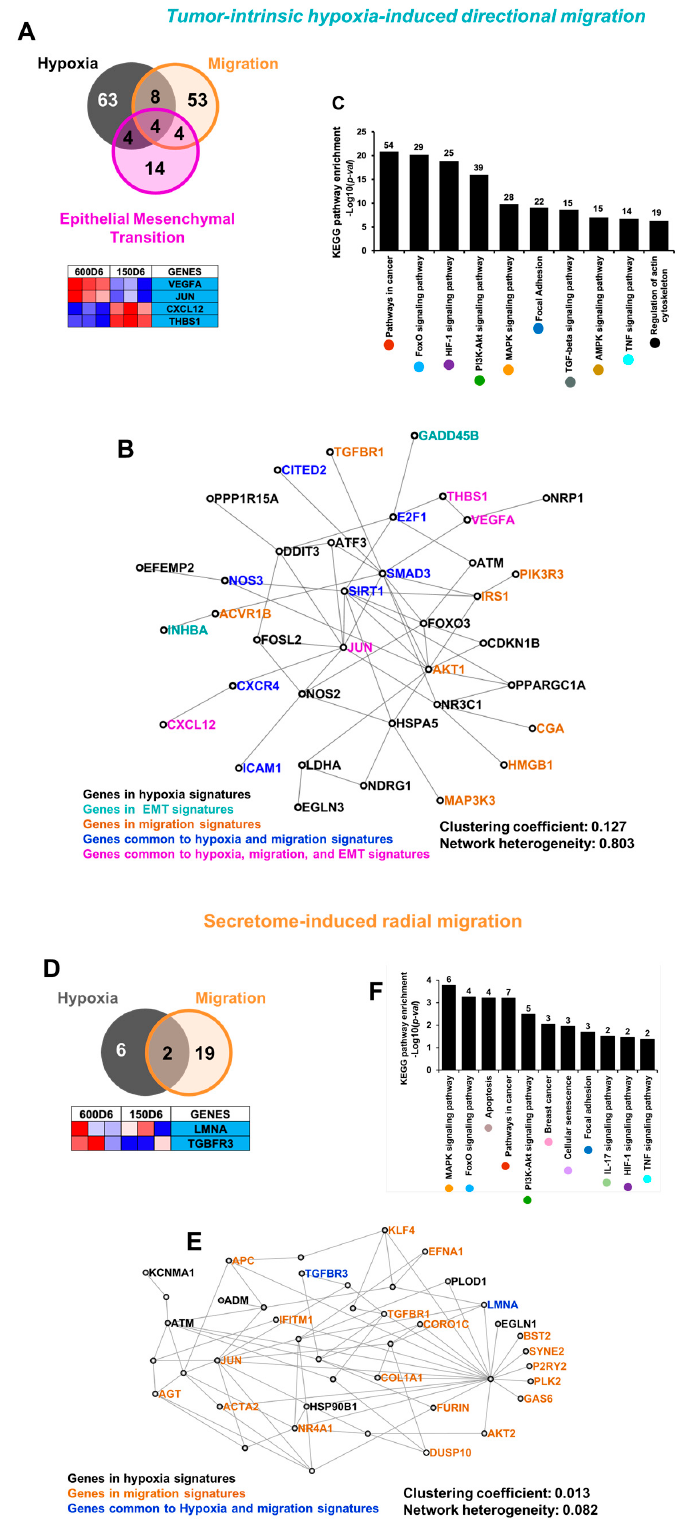
Figure 6. The drivers of directional vs. radial migration are different, have different PPI, and yet participate in the same migration-related signaling pathways: ( A ) Venn diagram showing the intersection of tumor-intrinsic hypoxia, EMT and directional migration signature sets. There are 8 genes common only between the hypoxia and migration signature gene sets, 4 genes common